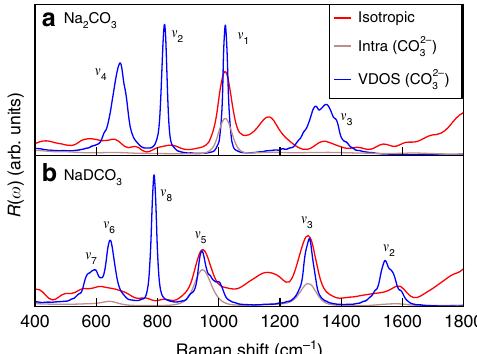
Fig. 3 Zoomed-in Raman spectra of 0.9 mol L − 1 solutions at ambient density and 380 K. Calculated spectra of the sodium carbonate and deuterated sodium bicarbonate solutions are shown in the upper and lower panels, respectively. The isotropic Raman spectra (red line), the intra- molecular Raman spectra (brown line), and the vibrational density of states (VDOS) (blue line) of CO 2 (cid:1) are compared. 3